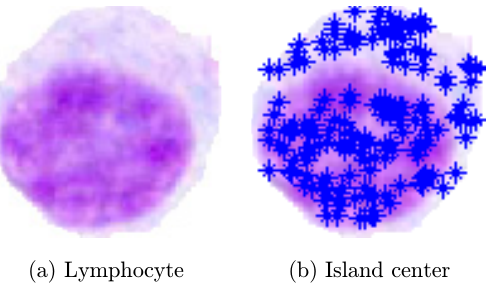
Fig. 3. Lymphocyte image processed by mean-shift modes ¯nding